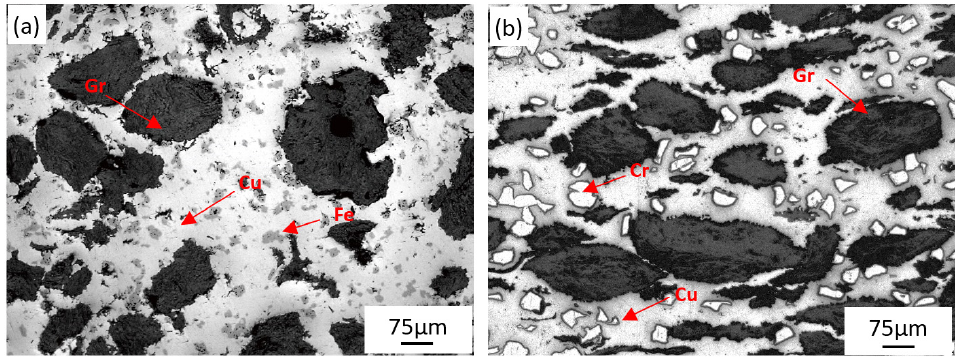
Figure 6. Microstructure of Cu–BCs: ( a ) Cu-Fe-Gr and ( b ) Cu-Cr-Gr. The Brinell hardness of Cu–BCs is presented in Figure 7. Fe and Cr phases had a hardness of HV 0.1 109 N/ μ m 2 and HV 0.1 248 N/ μ m 2 , respectively. Owing to the diffusion bonding interface formed between the friction component and matrix, the addition of a friction component can effectively improve the hardness of composites by means of par- ticle strengthening. Between them, because of higher hardness, Cr showed a better particle strengthening effect than Fe, though its interface strength is relatively lower. It can also be noticed that, owing to the low strength of the lubrication component, the addition of graphite led to an obvious decrease in the hardness of Cu–BCs.